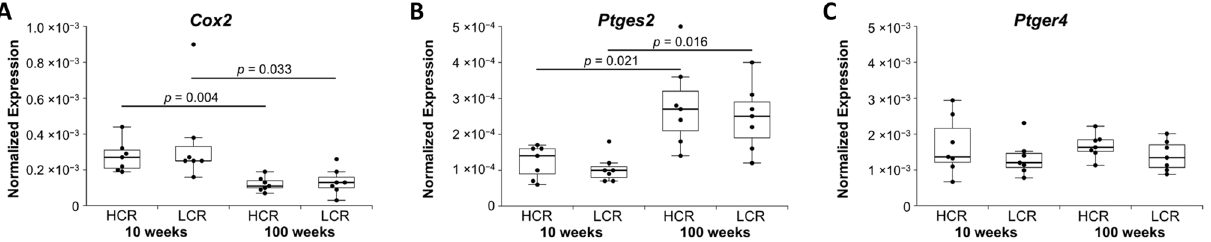
Figure 4. Normalized expression (NE) of ( A , B ) synthases and ( C ) receptor of prostaglandin E2. qRT-PCR data were normalized to the expression of the house keeping gene Rps18 . Results are shown as box plots with individual data points. Significant differences between two groups are marked as a line spanning between them with the p -value displayed above. p ≤ 0.05 was considered statistically significant.